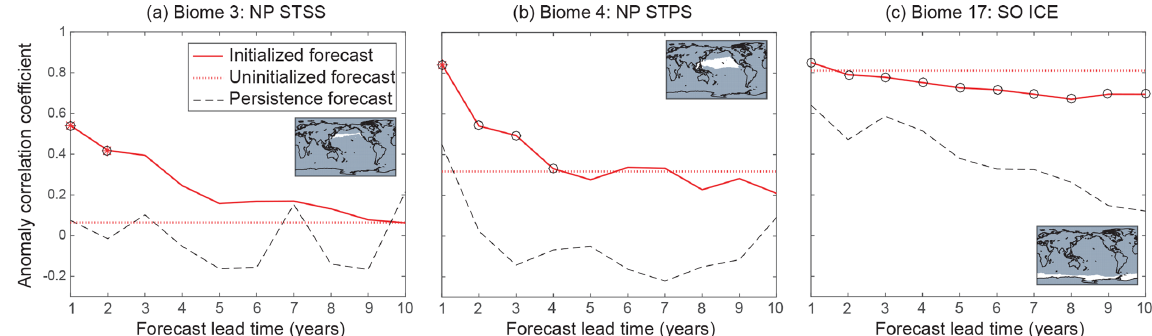
Figure 9. Predictability of biome-averaged CO 2 flux as a function of lead time in the (a) NP STSS, (b) NP STPS, and (c) SO ICE biomes, as indicated by the correlation coefficient of detrended CO 2 flux anomalies from the (red) CESM-DPLE initialized forecast and the (red dotted) CESM-LE uninitialized forecast with the reconstruction. The black dashed line shows the correlation coefficient of the persistence forecast as a function of lead time. Red asterisks (black circles) on the initialized forecast indicate predictability that is statistically different from the initialized (persistence) forecast at the 95% level using a z